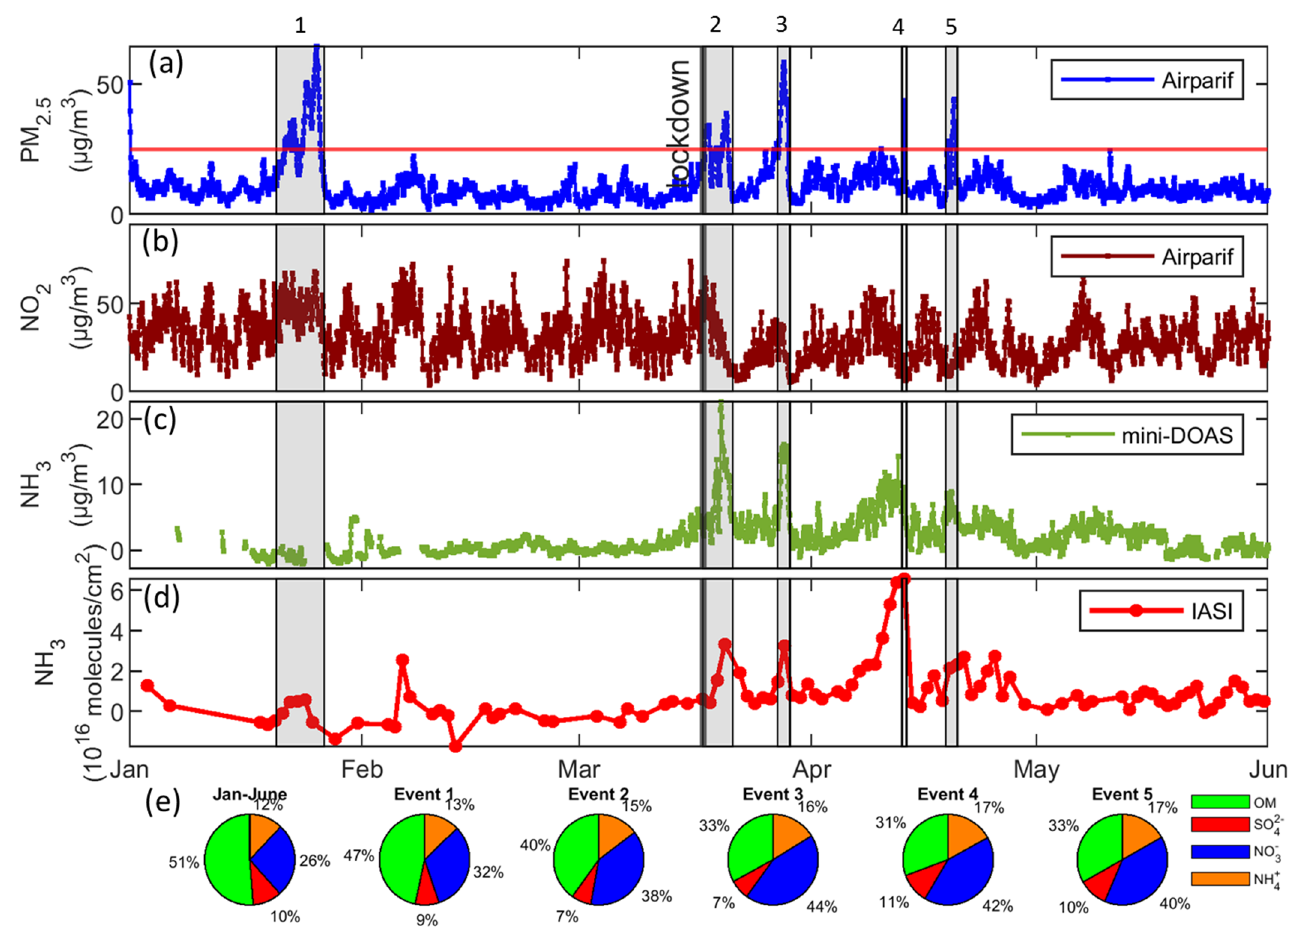
Figure 2. Time series of hourly PM 2.5 and NO 2 concentrations ( µ g/m 3 ) derived from the Airparif network ( a , b ), hourly NH 3 concentrations ( µ g/m 3 ) derived from the mini-DOAS ( c ), daily Infrared Atmospheric Sounding Interferometer (IASI) NH 3 total column (molecules/cm 2 ) measured in a 50 km radius circle from Paris city center ( d ), and mean relative contributions of major PM 1 chemical species (OM: organic matter, SO 42 − : sulfate, NO 3 − : nitrate, and NH 4+ : ammonium) measured at SIRTA from January to June 2020, and for the 5 investigated periods ( e ).